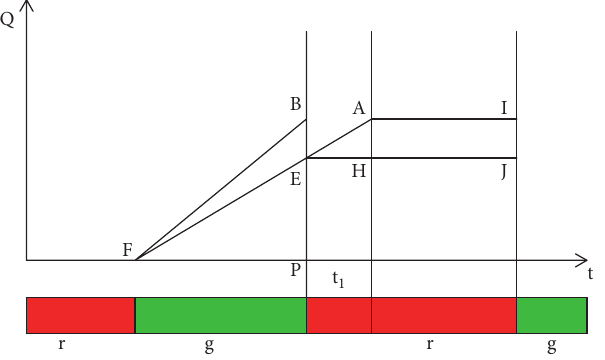
Figure 2: Queue length and delay time with the tail vehicles of discrete traffic flows were truncated.